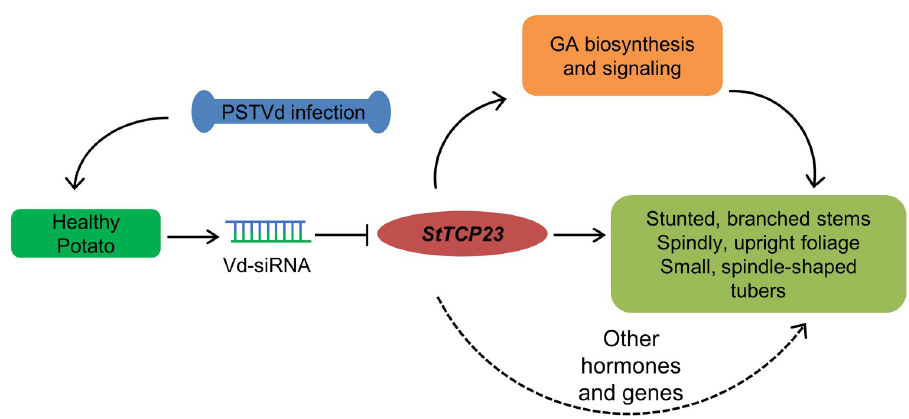
Fig 8. Effects of PSTVd-mediated silencing of StTCP23 silencing on plant development. Solid lines, regulatory links observed in our experiments; dashed lines, possible regulatory links observed in other studies. Arrows indicate positive regulation; blunt ended bars indicate